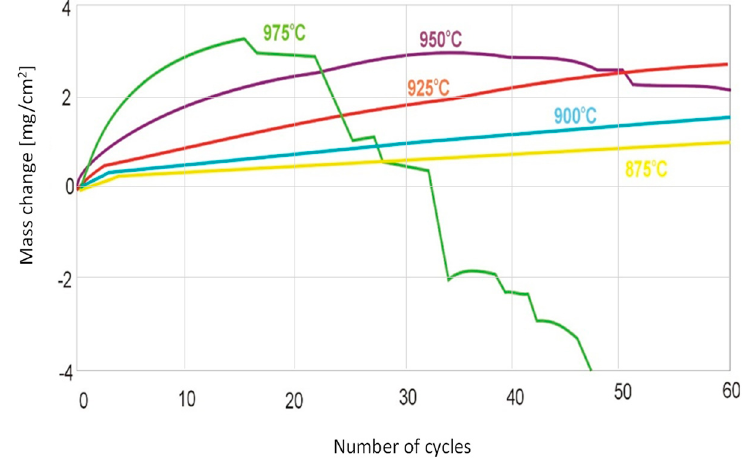
Figure 2. Mass change of Ti-46Al-7Nb-0.7Cr-0.1Si-0.2Ni per unit area with respect to exposed temperature.